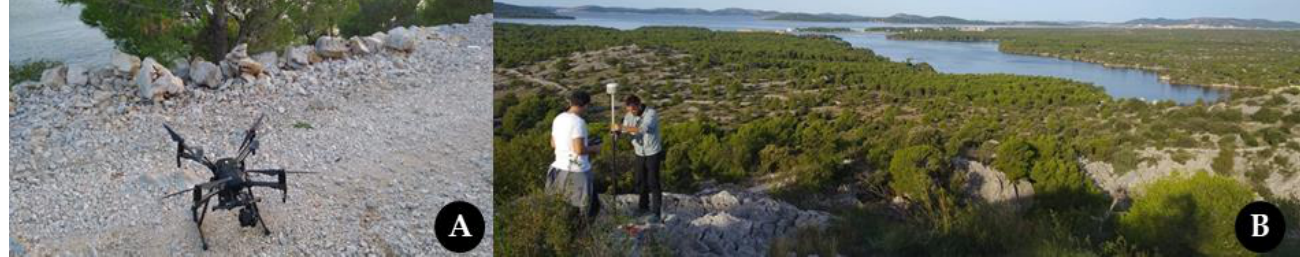
Figure 3. ( A ) The UAV Matrice 210 RTK V2 ; ( B ) the collecting ground control (GCP) and check point